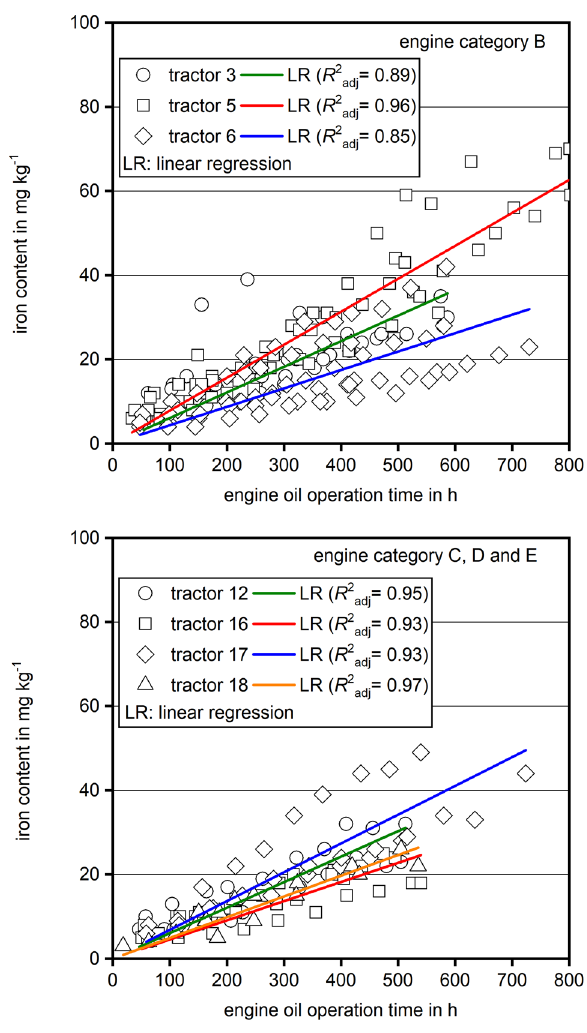
Fig. 5 Iron content of the engine oil in relation to the engine oil operation time for different tractors